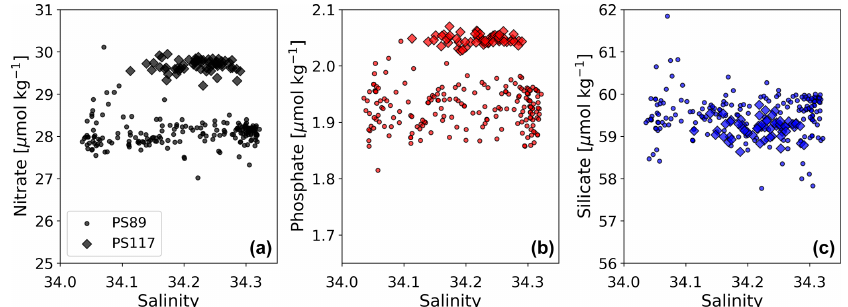
Figure G5. Salinity-normalised (following Friis et al., 2003) nitrate ( a , black), phosphate ( b , red), and silicate ( c , blue) content plotted against salinity for the PS89 (circles) and PS117 (diamonds) tidal observations.